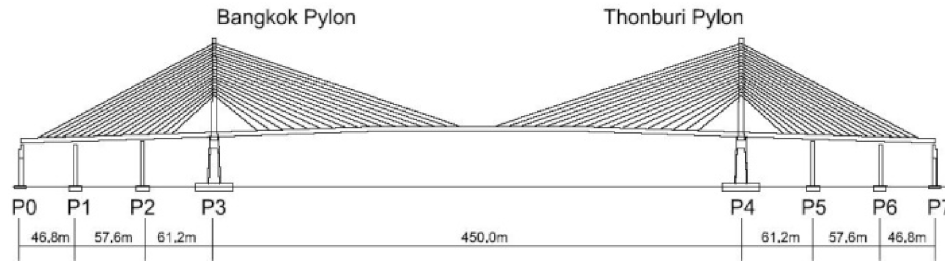
Figure 6. Profile of the bridge used in the present study.